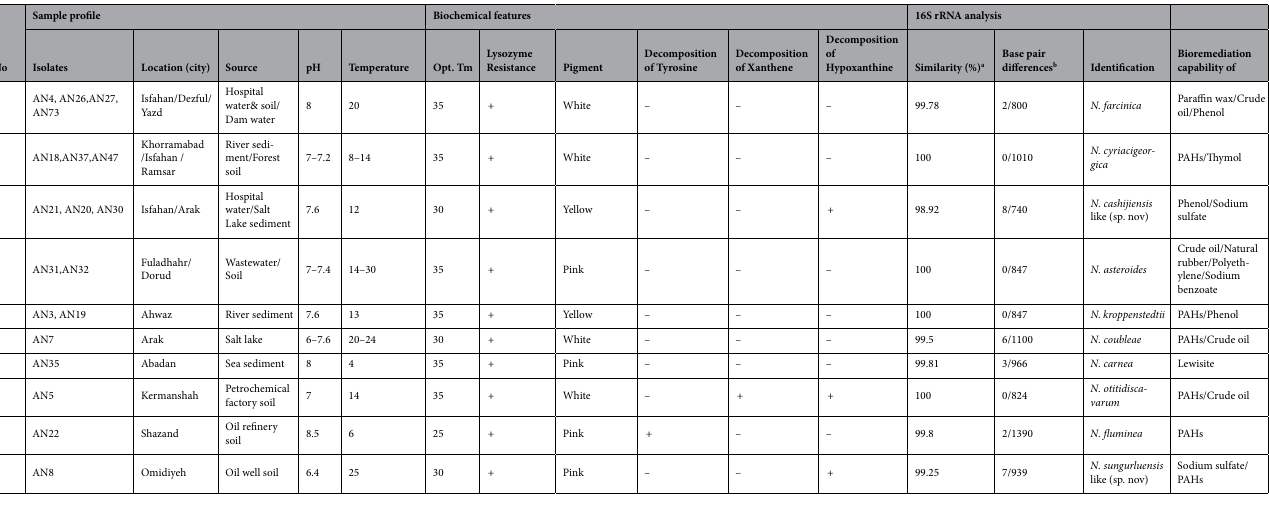
Table 2. Samples profile, phenotypic and molecular features and bioremediation capability of Nocardia isolates from Iranian ecosystems. a Similarity; % similarity to the nearest validated species. b Base pair differences: the number of nucleotide differences between the isolates and the nearest validated